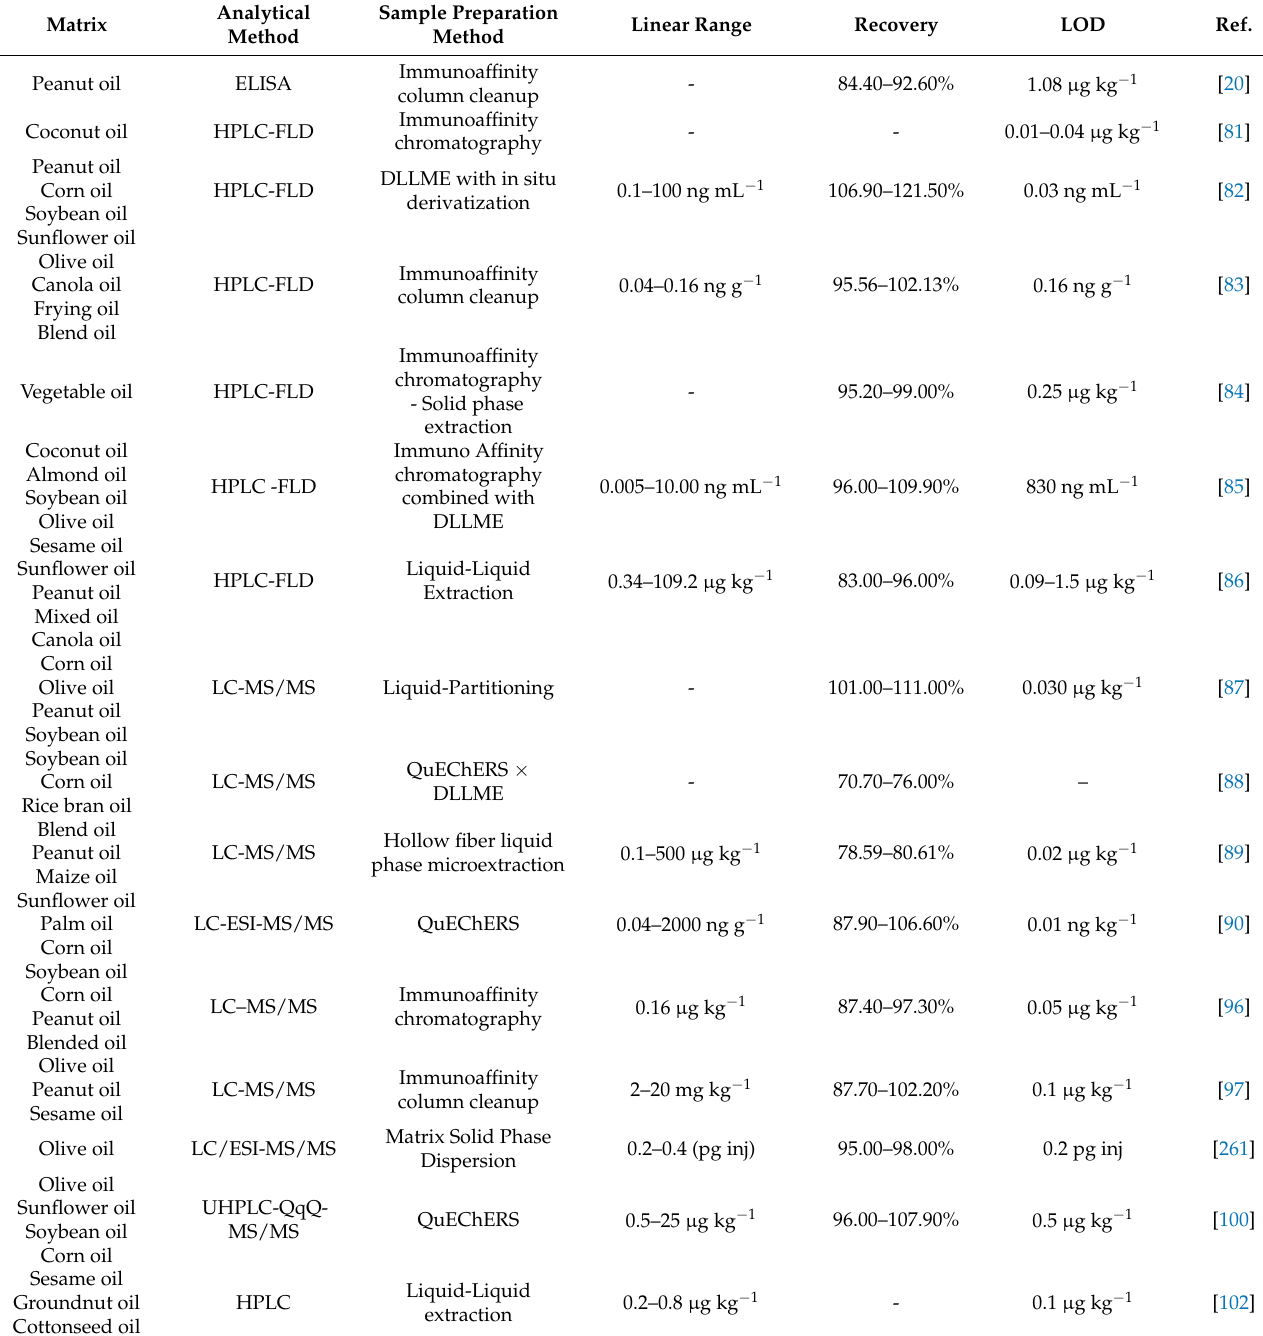
Table 2. Techniques used for the detection of AFB 1 in different types of edible